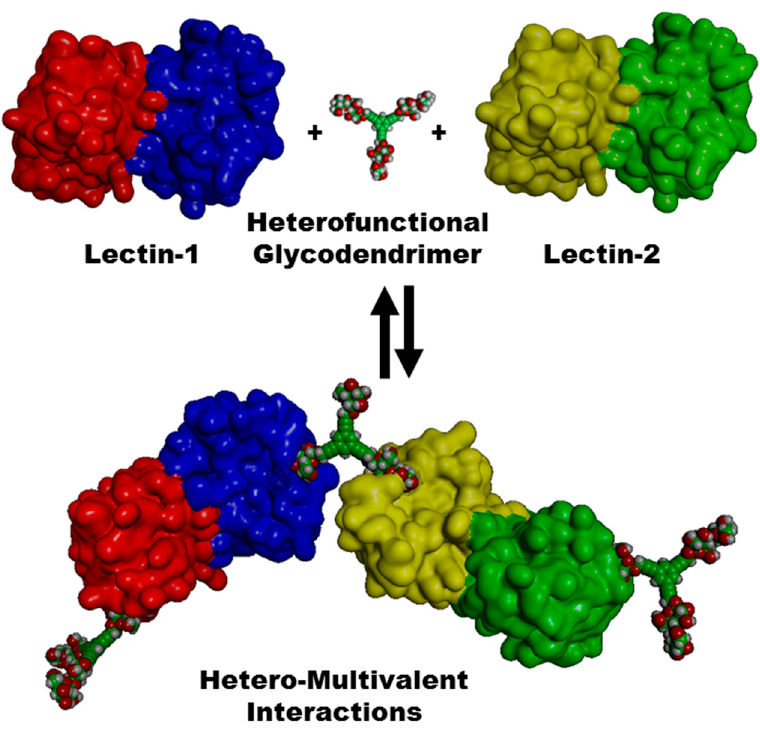
Figure 1. Heterofunctional glycodendrimers have the capacity to bind different lectins through multivalent cross-linking interactions.